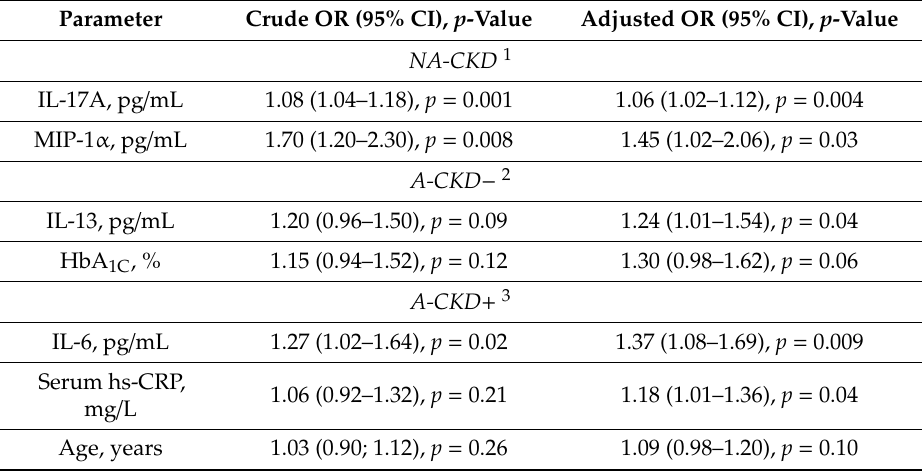
Table 4. Predictors of di ff erent CKD patterns in T2D